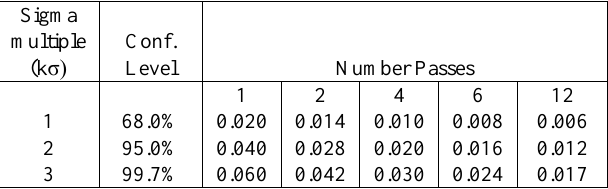
Table 1. Theoretical vertical (1-D) accuracy